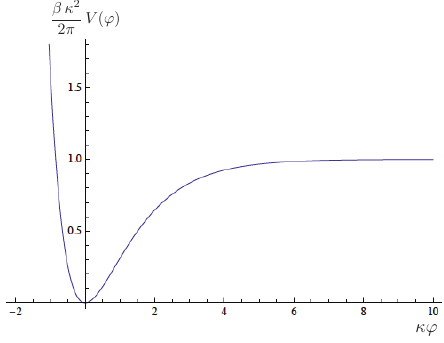
Figure 1. The effective potential (8) of the collective scalar field ϕ that describes the one-loop quantum fluctuations of matter fields, leading to the higher-order scalar curvature corrections in the Starobinsky model for inflation (5). Notice that according to (8), we have β = 8 π /3 M 2 . The potential is sufficiently flat for κϕ (cid:29) 1 to ensure slow-roll conditions for inflation are satisfied, in agreement with the Planck (cid:112) β ∝ M (which sets the overall scale of inflation in data, for appropriate values of the scale 1/ the